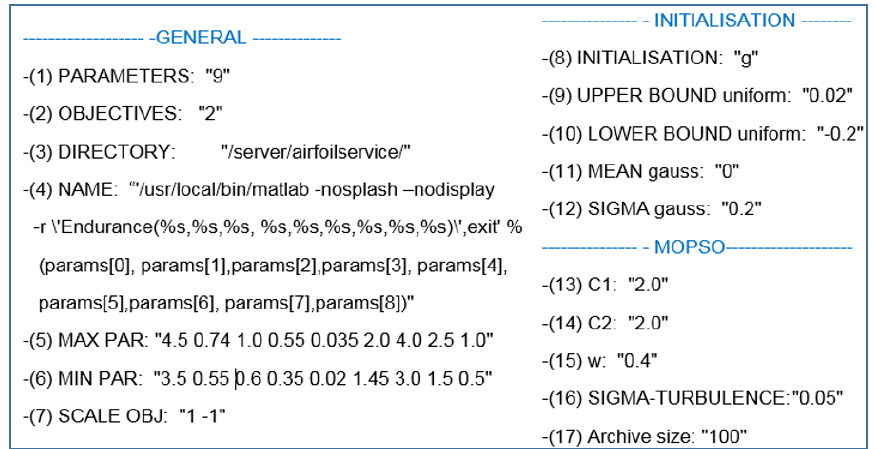
Figure 12. Setting for Input file. Design variables characteristics, location of the external model, and MOPSO setting.